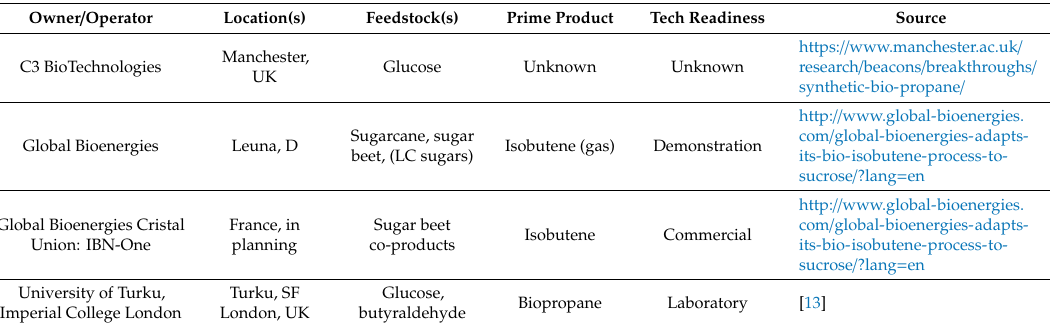
Table 5. Fermentation projects relevant to